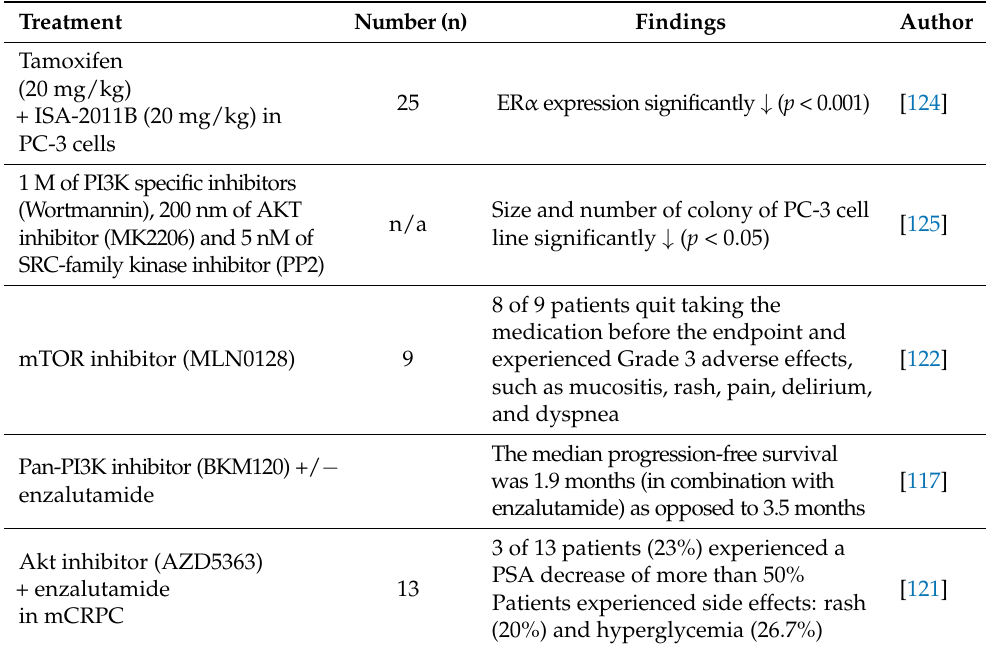
Table 3. Application of selective inhibitors in castration-resistant prostate cancer treatments.